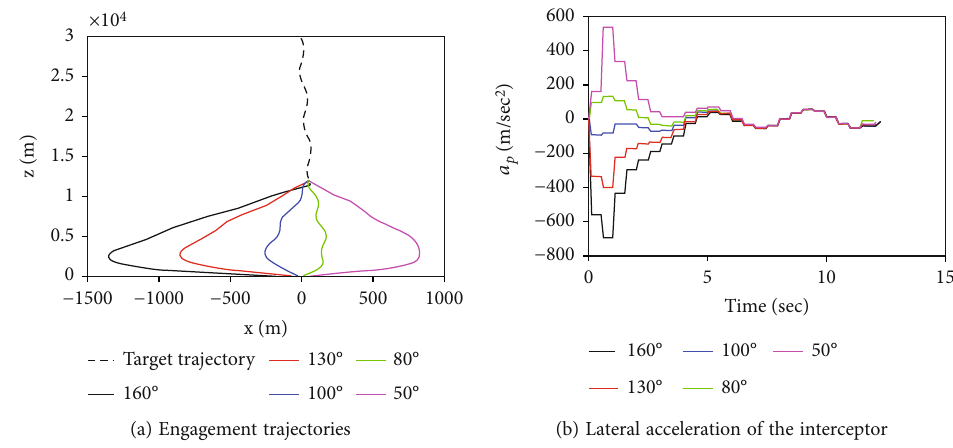
Figure 8: Di ff erent initial heading angles of interceptor. Table 2: Simulation data based on references [6, 7, 12, 13, 27].